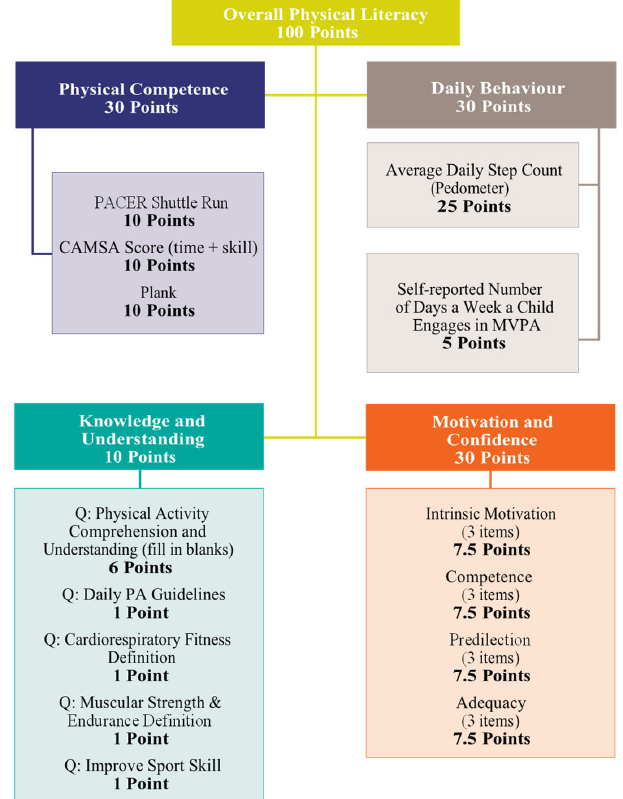
Figure 2. CAPL ‐ 2 domains and comprehensive scoring system adapted from CAPL ‐ 2 manual Figure 2. CAPL-2 domains and comprehensive scoring system adapted from CAPL-2 manual HALO HALO (2017) [31,45,46]. (2017)